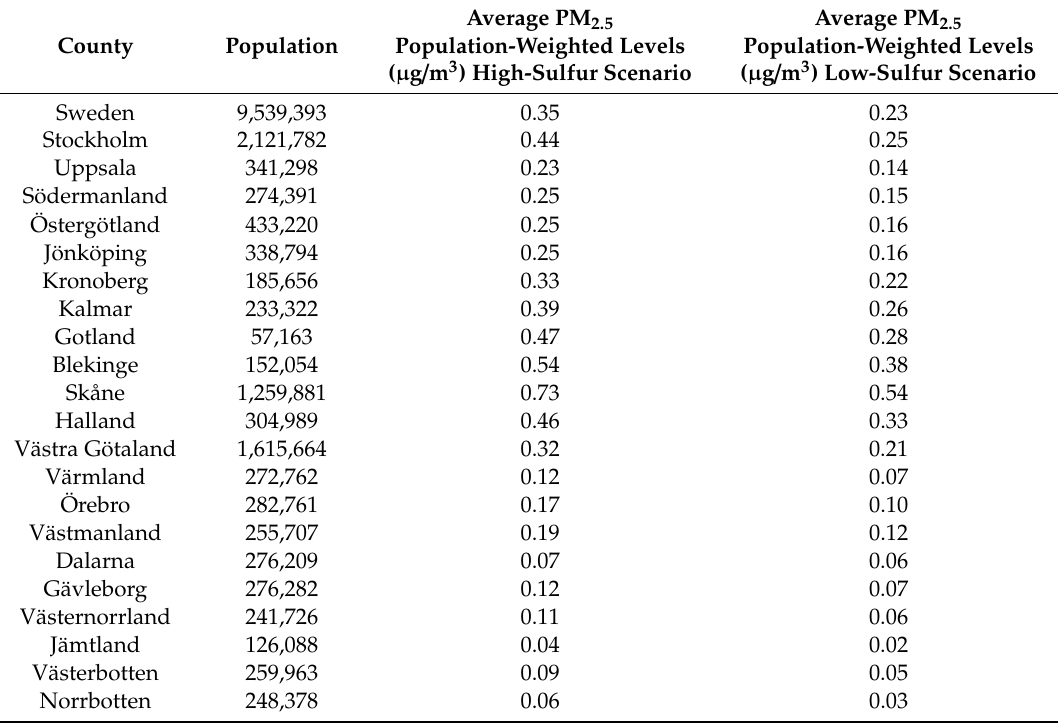
Table 1. Sweden’s 21 counties, populations in 2015, and population-weighted PM 2.5 levels of exposure due to shipping using the regional model (1 × 1 km) grids, using both high- and low-sulfur scenarios.